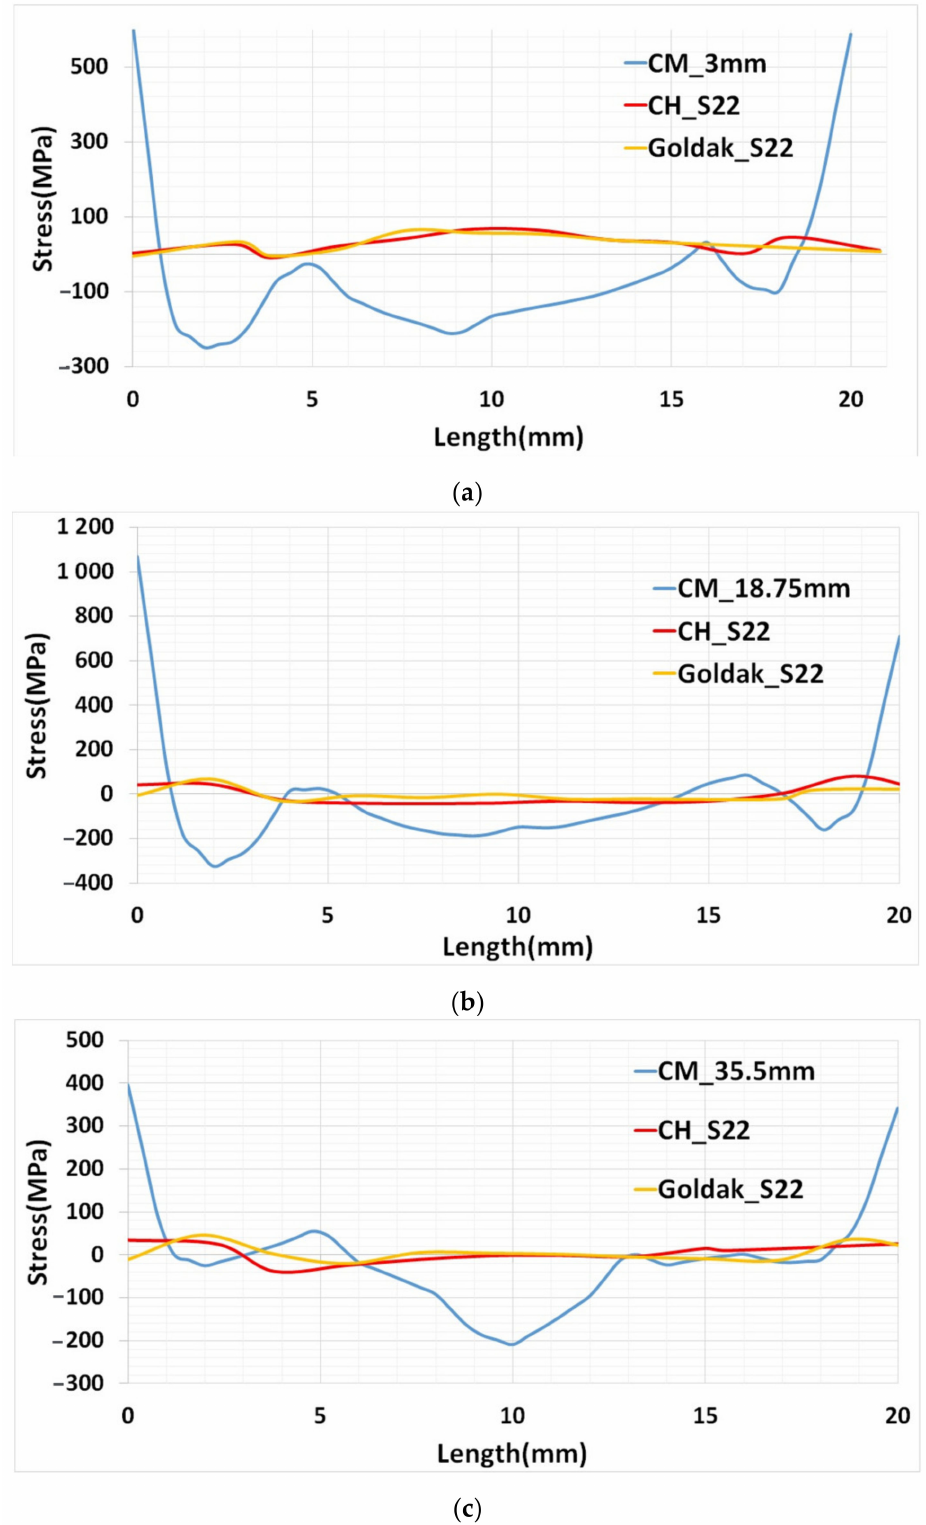
Figure 17. Residual stress comparison between simulation and experimental results ( a ) Path-1 ( b ) Path-2 ( c )